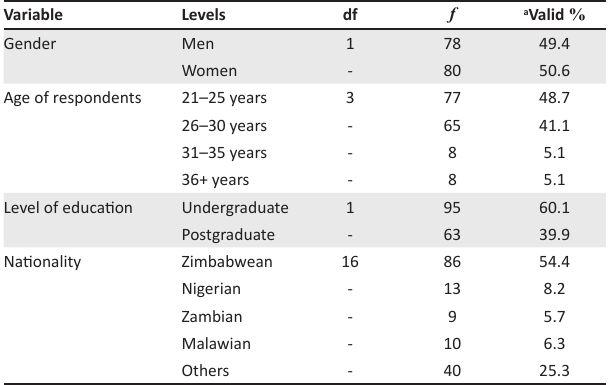
TABLE 2: Descriptive statistics for biographical variables ( n =